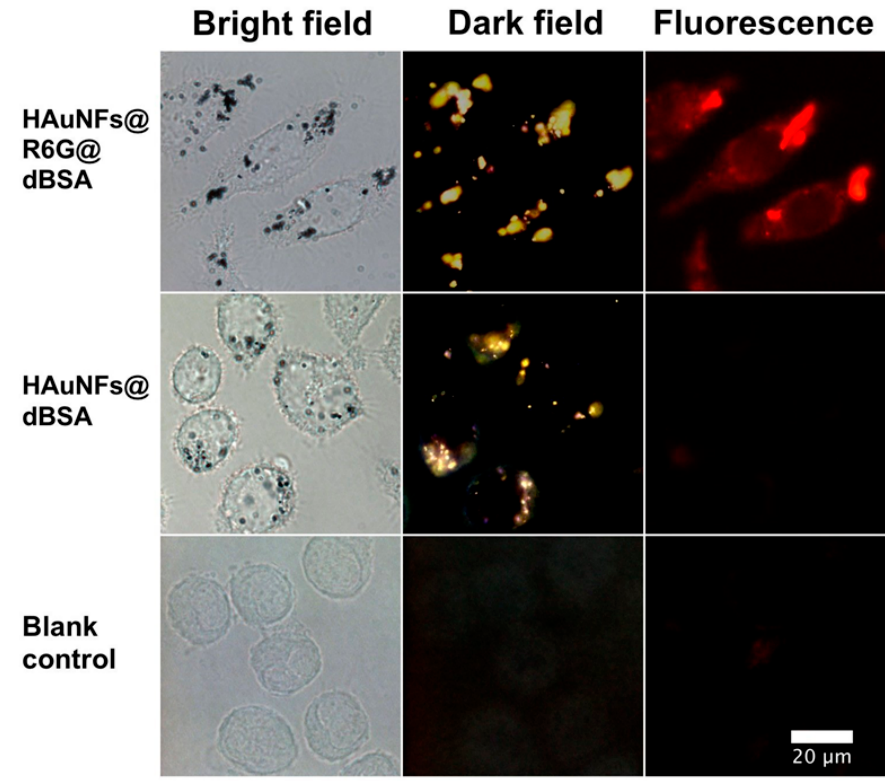
Figure 4. Bright-field, dark-field, and fluorescent microscopy images of RAW 264.7 cells after 12 h of incubation in a medium containing HAuNFs@R6G@dBSA, HAuNFs@dBSA, or medium only as a blank control. (Wider-view bright-field microscopy images of cells treated with HAuNFs@R6G@dBSA or HAuNFs@dBSA are shown in Supplementary Materials, Figures S1 and